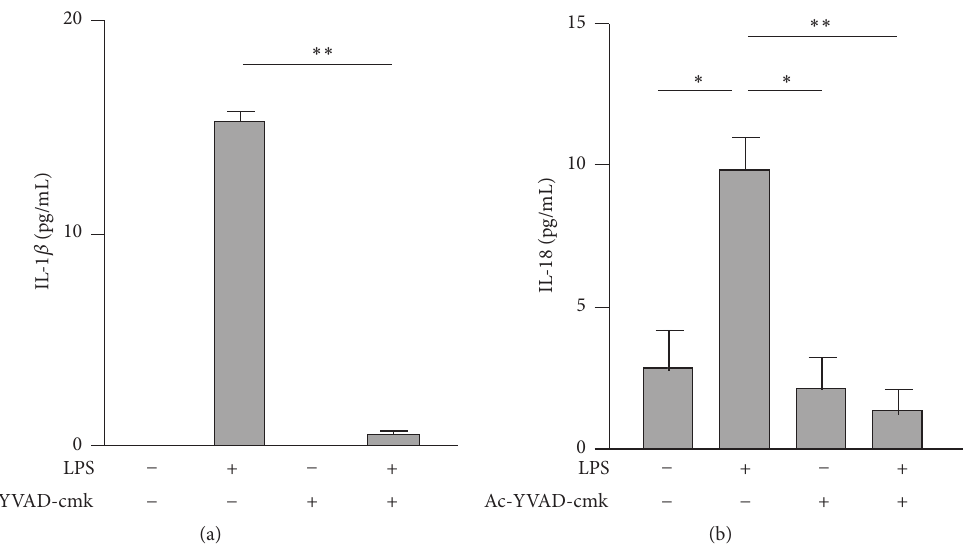
Figure 8: Effects of Ac-YVAD-cmk on the secretion of interleukin- (IL-) 1 𝛽 and IL-18 from macrophages stimulated with or without lipopolysaccharide (LPS). Peritoneal-exudate macrophages were simultaneously treated with 100ng/mL LPS and 10 𝜇 M Ac-YVAD-cmk. Concentrations of interleukin IL-1 𝛽 (a) and IL-18 (b) in the cell culture supernatants were quantified by enzyme-linked immunosorbent assay (ELISA). Mean ± standard error of the mean (SEM; 𝑛 = 3 ) values are provided. ∗ 𝑝 < 0.05 ; ∗∗ 𝑝 < 0.01 (by one-way analysis of variance [ANOVA] and the Bonferroni test).